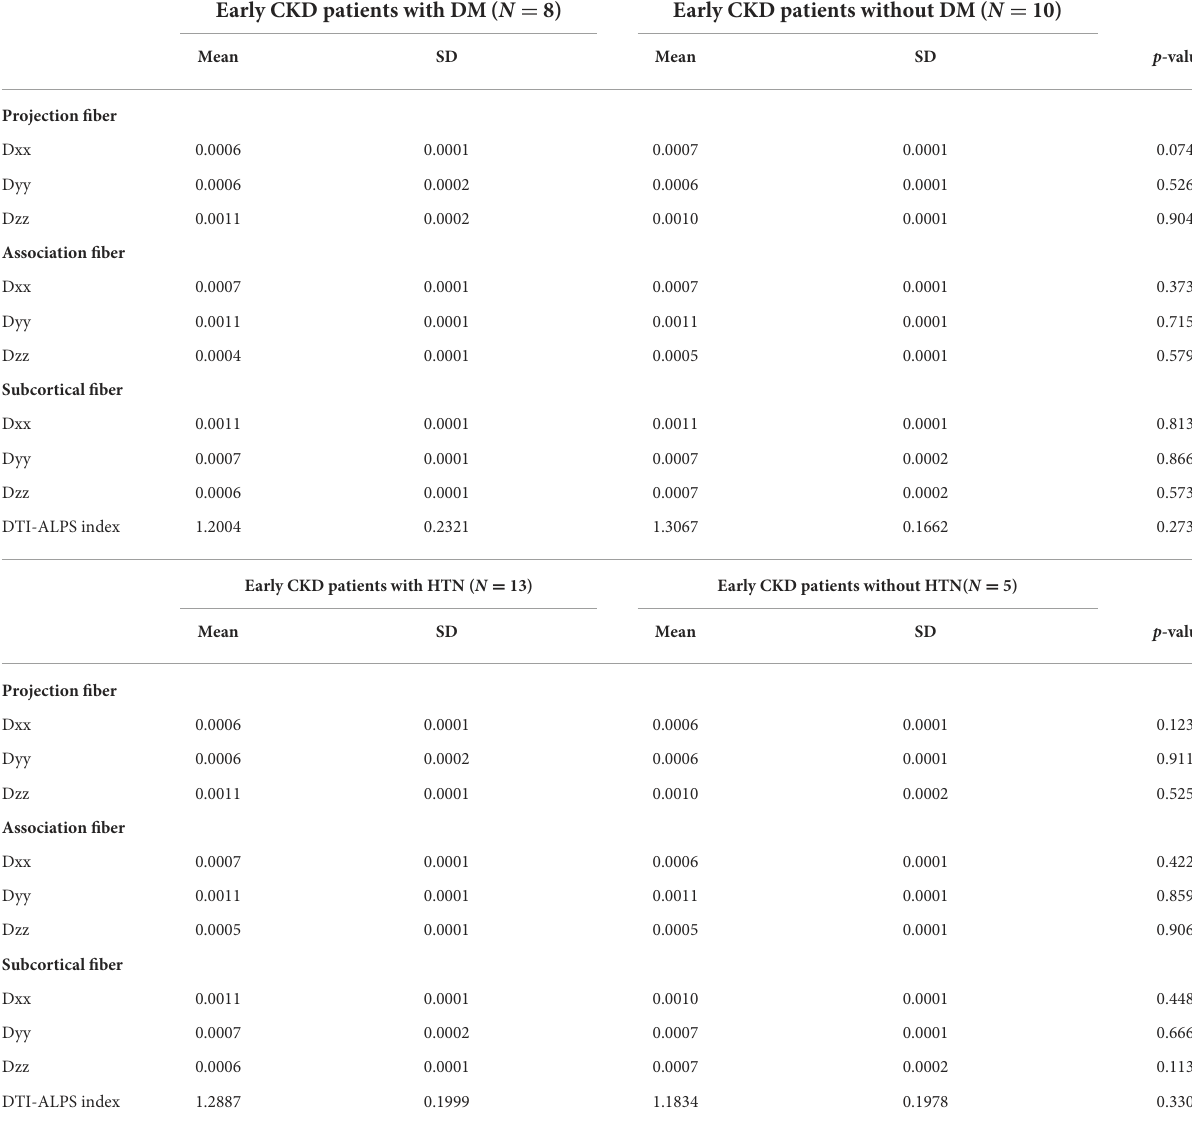
TABLE 3 The differences of the diffusivities along the axis in the fibers between early CKD patients with or without comorbidities. Early CKD patients with DM ( N = 8) Early CKD patients without DM ( N = 10) Mean SD Mean SD p